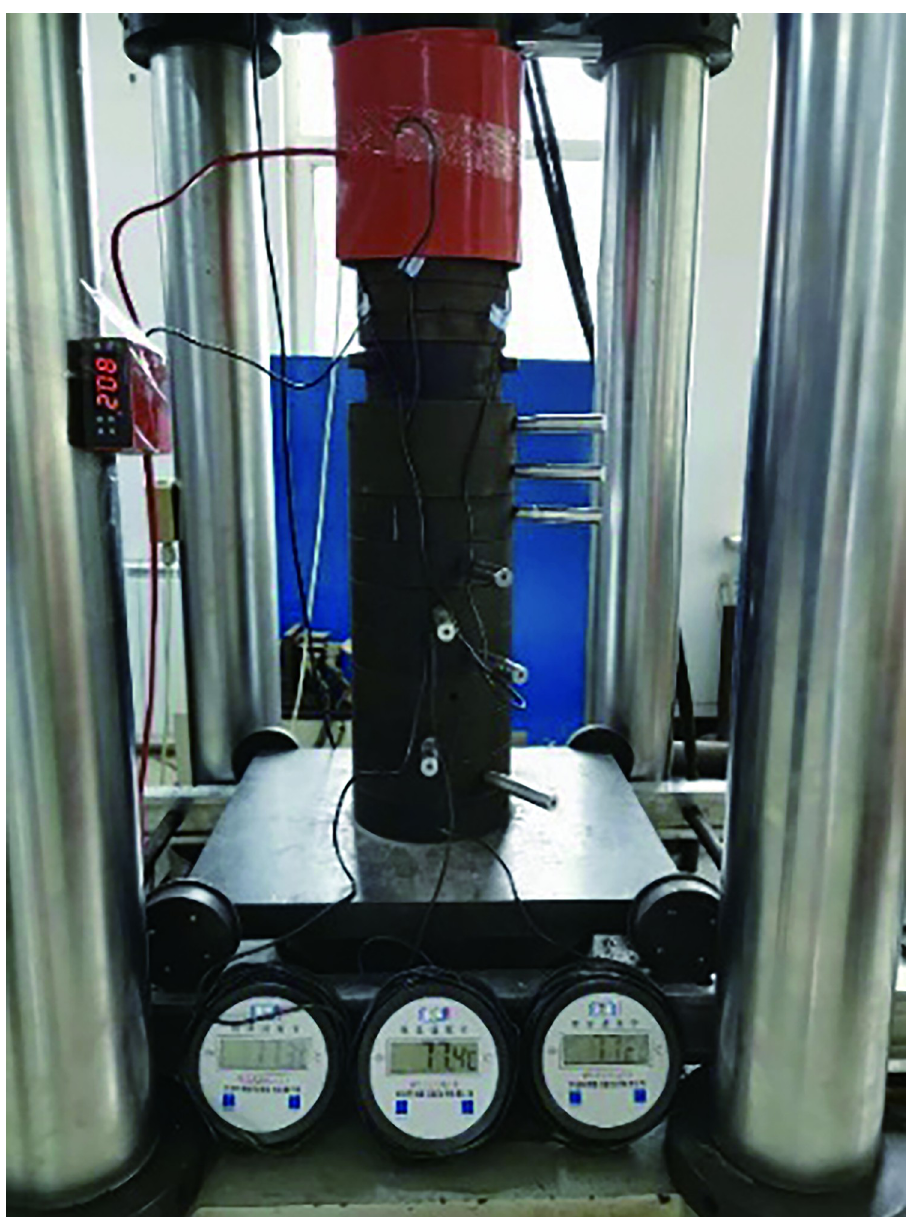
Fig 17. Photograph showing the experimental procedure